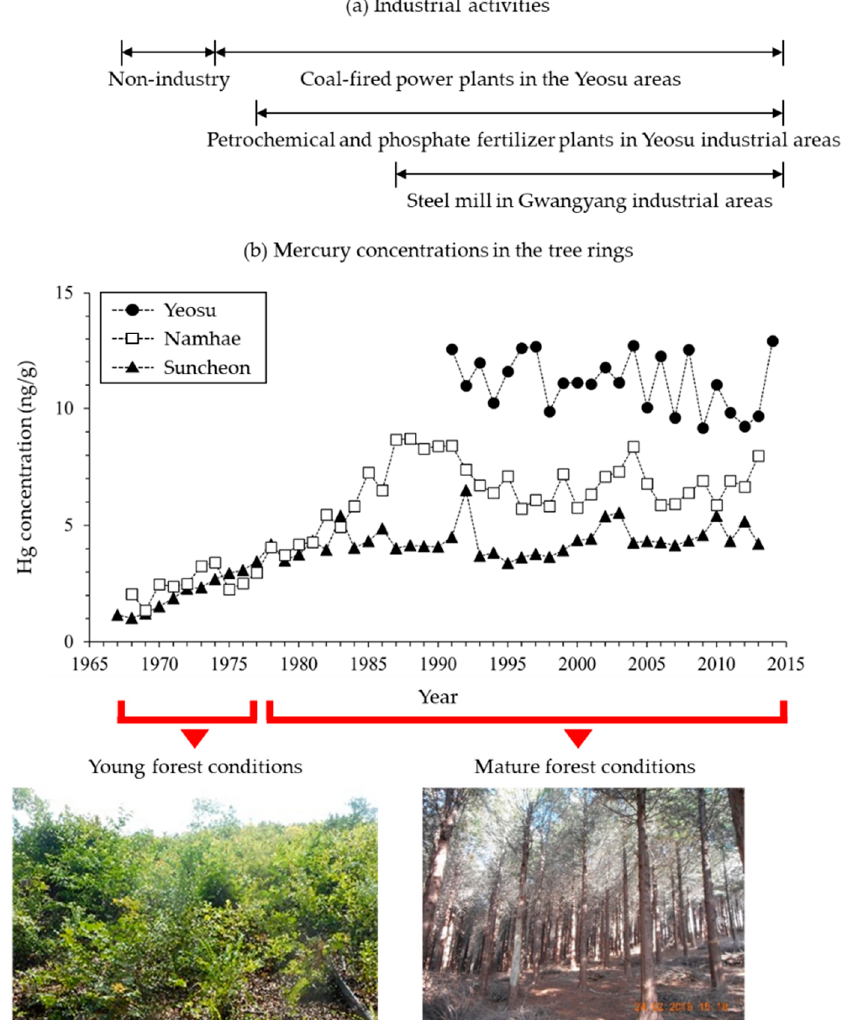
Figure 3. Relationship between industrial activities at Yeosu and Gwangyang industrial areas ( a ), historical distribution of Hg concentrations in Japanese cypress trees at Yeosu, Namhae, and Suncheon sites according to forest conditions ( b ).